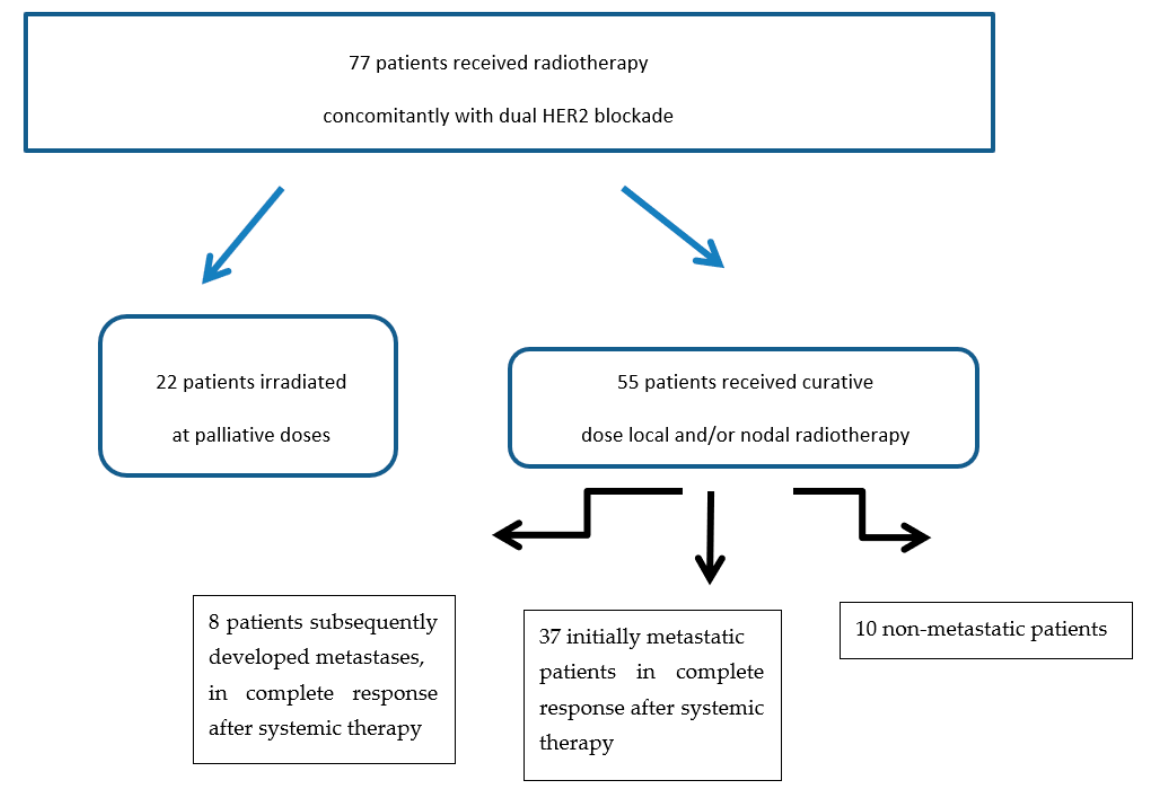
Figure 1. Figure 1. Flowchart.